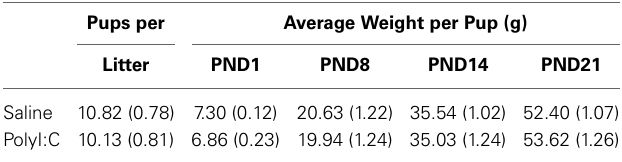
Table 1 | Number and weight of the pups born to the saline- and polyI:C-treated